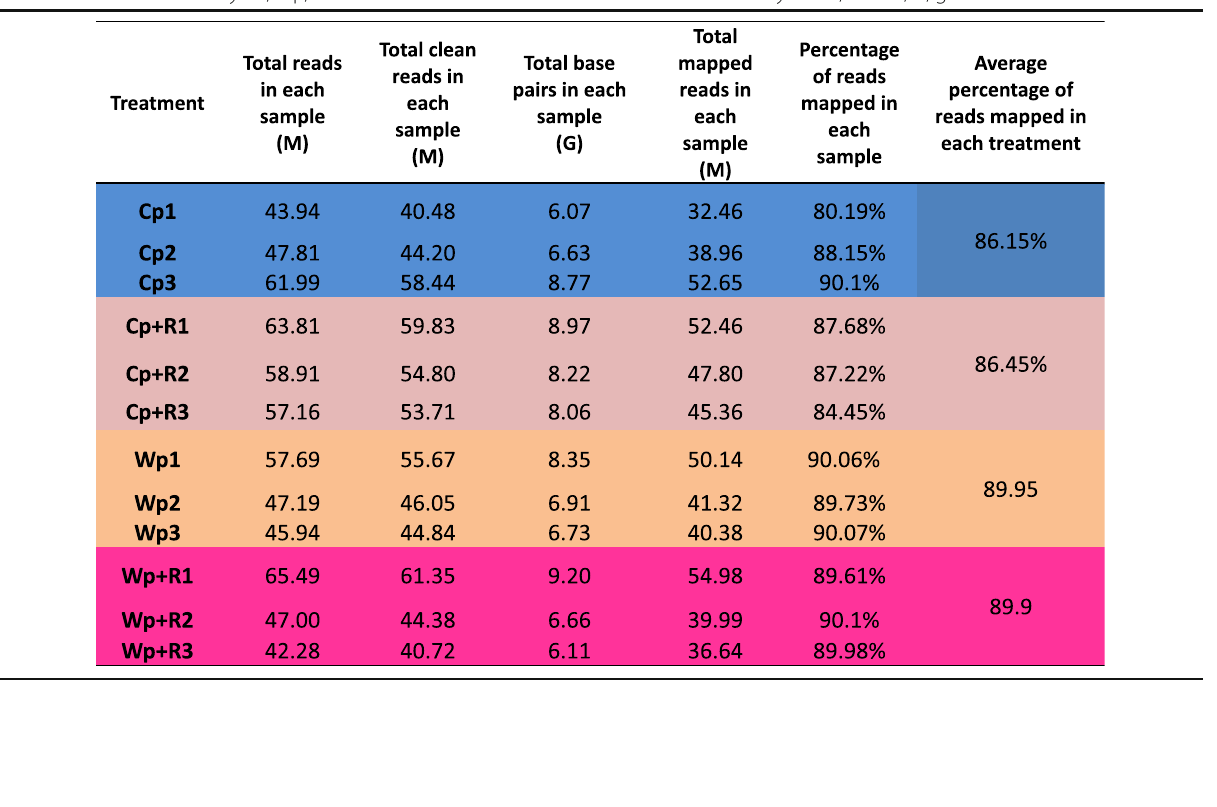
Table 1 Summary of Illumina RNA-sequencing reads mapped to the reference genome. Cp+ R, Rhizoglomus intraradices -inoculated cultivated rice infected with Magnaporthe oryzae ; Cp, R. intraradices -uninoculated cultivated rice infected with M. oryzae ; Wp+ R, R. intraradices -inoculated